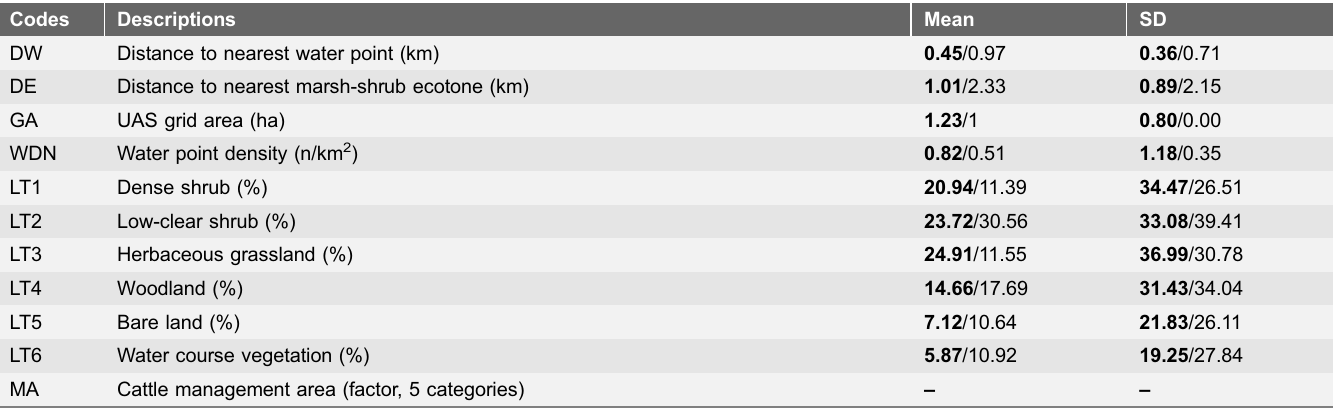
Table 1. Environmental predictors used for spatial modelling of both host species abundance and Mycobacterium tuberculosis complex transmission risk